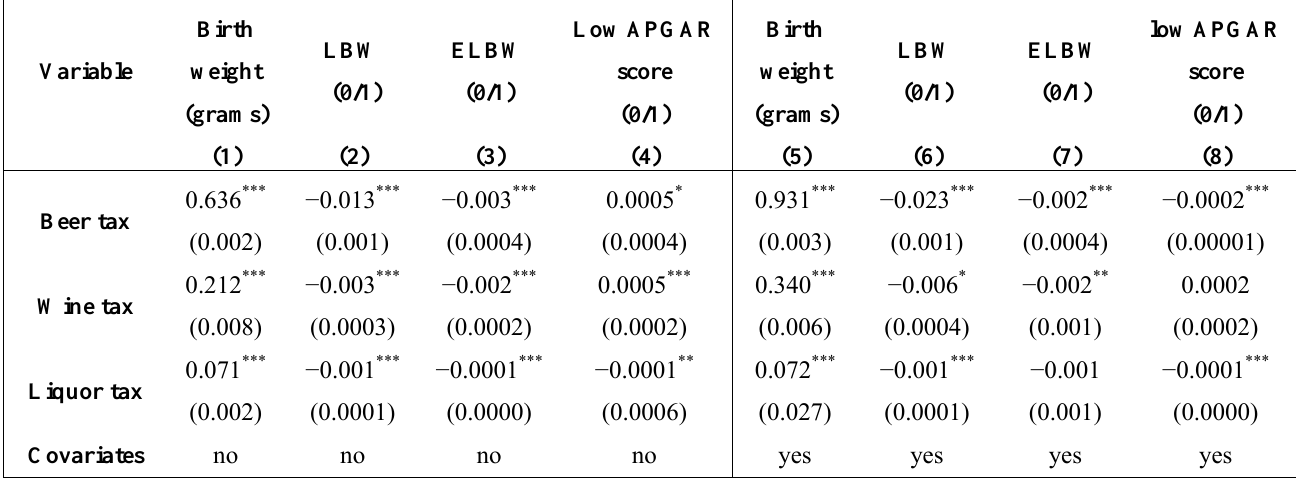
Table 4. Alcohol Taxes and Infants Health (Natality